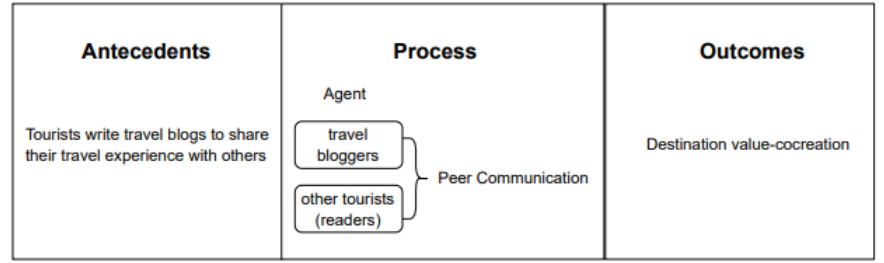
Figure 1. Consumer socialization through social media.